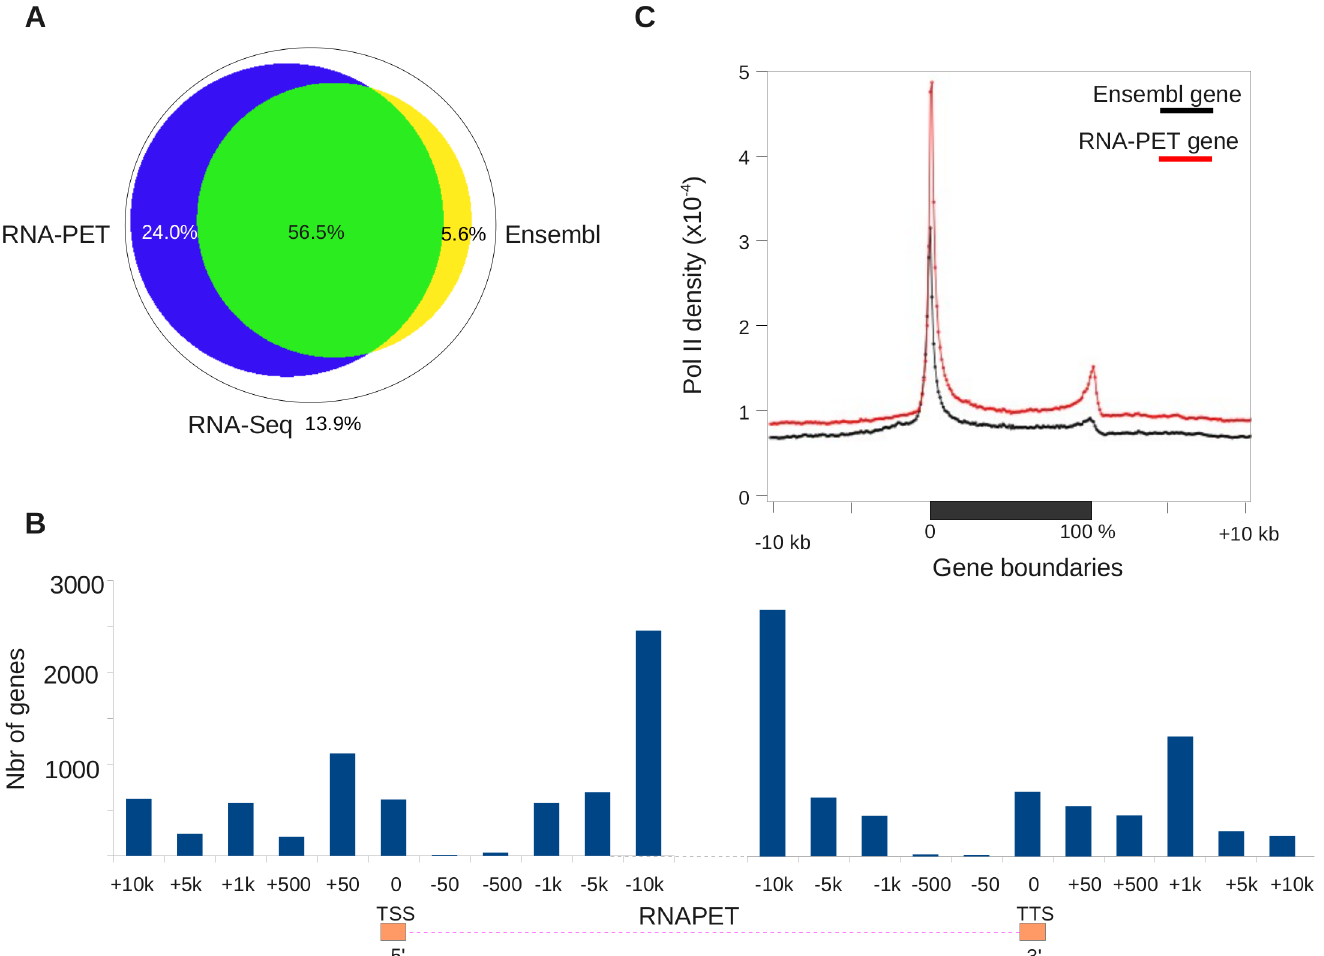
Fig 2. RNA-PET efficiently captures transcripts ends. A. Overlap between RNA-Seq reads and Ensembl and RNA-PET-based models. B. Demarcation of gene model boundaries by RNA-PET. The histogram shows the relative size of Ensembl gene models in bins of various sizes. C. Enrichment of RNA-Pol II around Ensembl gene models and RNA-PET-based models. This shows that RNA-Pol II density fits well with RNA-PET based models, but not Ensembl models.